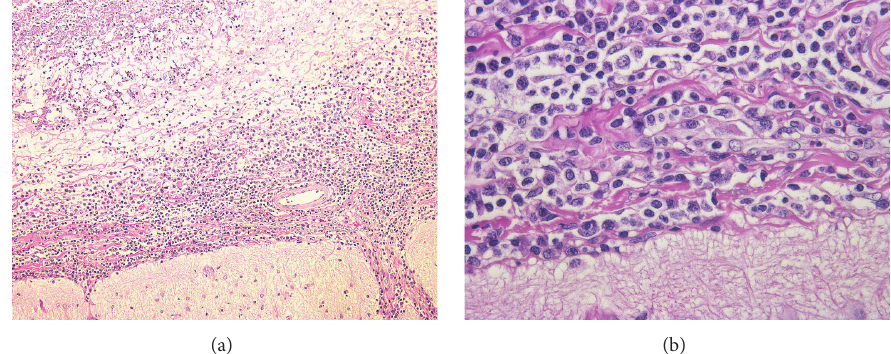
Figure 3: Brain biopsy. Microscopic view of biopsied specimen showed leptomeningitis with plasma cells and lymphocytes infiltration. Haematoxylin and eosin stain, magnification of (a) 100x and (b)